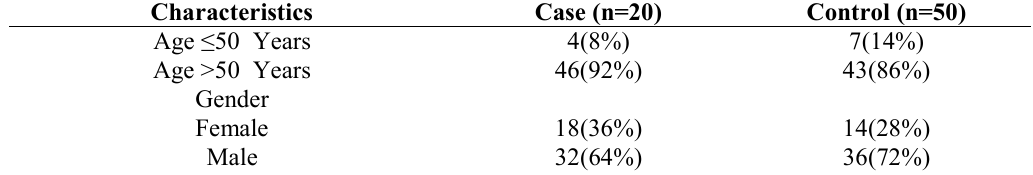
Table 1. General characteristics of participants.